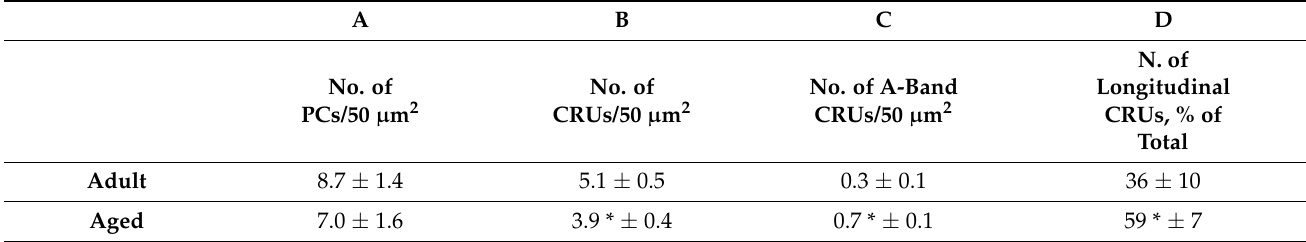
Figure 6. Representative EM images and relative quantitative analyses of couplons. ( A ) A representative CRU in an adult cardiomyocyte formed by two couplons, i.e., a single T-tubule associated with two SR elements. ( B , C ) Representative CRUs in aged cardiomyocytes formed by a single T-tubule associated with either a single or multiple SR elements. ( D ) An enlargement of the red box in panel A: the width of the junctional SR (jSR) is shown by small arrows. Legend: SR is false-labeled in yellow; blue dots in panel D mark the position of RYR2. Scale bars: ( A – C ), 0.1 μm; ( D ), 0.05 μm. Table 2. Quantitative analyses of number and size of couplons. Table 1. Quantitative analysis of PCs, CRUs, and of not properly positioned CRUs (at the A-band or longitudinally oriented). A